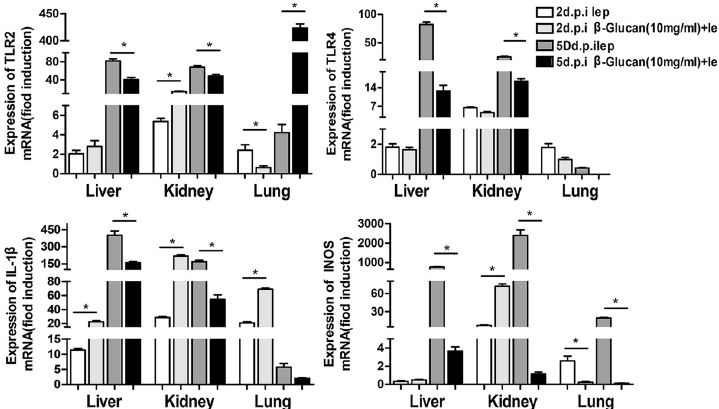
Fig 2. Modulation of TLR2, TLR4, IL-1 β and iNOS mRNA expression in tissues after injection of leptospires. The TLR2, TLR4, IL-1 β and iNOS mRNA levels in the kidneys, livers, and lungs of hamsters at 2 dpi and 5 dpi were quantified by RT-qPCR. The results were normalized to the expression level of the housekeeping gene GAPDH. The bars show the levels of TLR2, TLR4, IL-1 β and iNOS (means ± standard deviations) in each tissue of hamsters (n = 3). The levels of TLR2, TLR4, IL-1 β and iNOS in different tissues from three healthy individuals at 0 h were assigned a value of 1.0. Different mRNA expression levels between the infected group and the healthy group (0 h) were compared by one-way ANOVA. � , P <